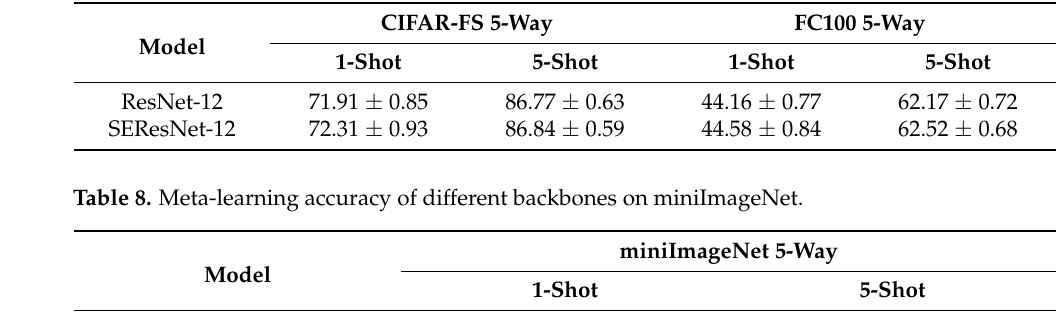
Table 7. Meta-learning accuracy of different backbones on CIFAR-FS and FC100.